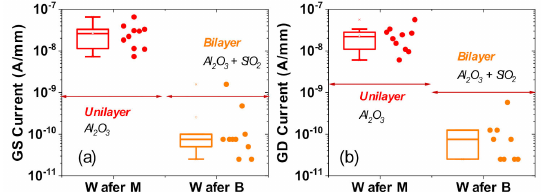
Figure 3. Comparison of diode leakage behavior between Wafer M (uni-layer oxide) and Wafer B (bilayer oxide). ( a , b ) show statistical results of the current level at V GS = 8 V ( a ) and V GD = 8 V ( b ).